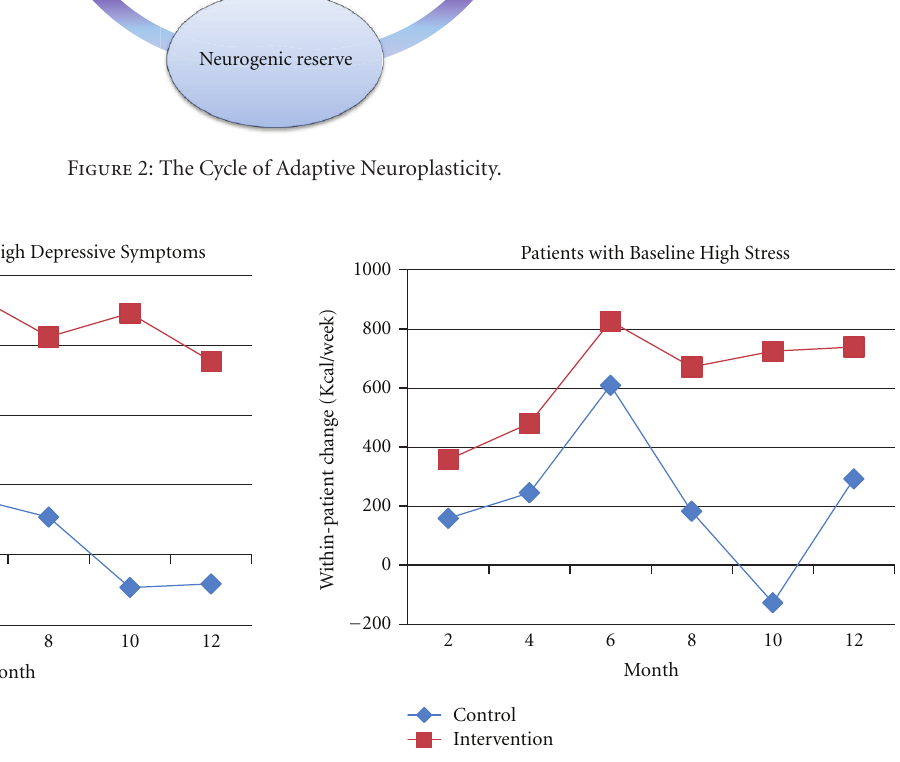
Figure 4: Physical activity expenditure over 12 months in the positive a ff ect intervention versus control group among patients with high stress at